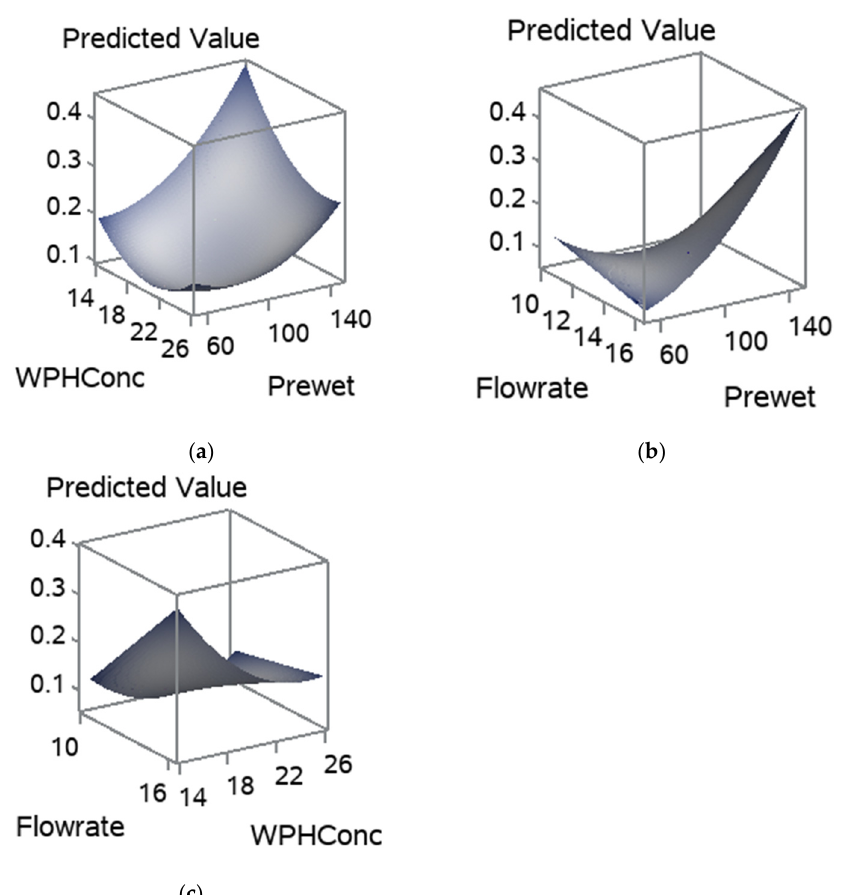
Figure 4. Response surface for MC, ( a ) pre-wet mass vs. WPH concentration; ( b ) flow rate and pre-wet mass; and ( c ) WPH concentration and flow rate.